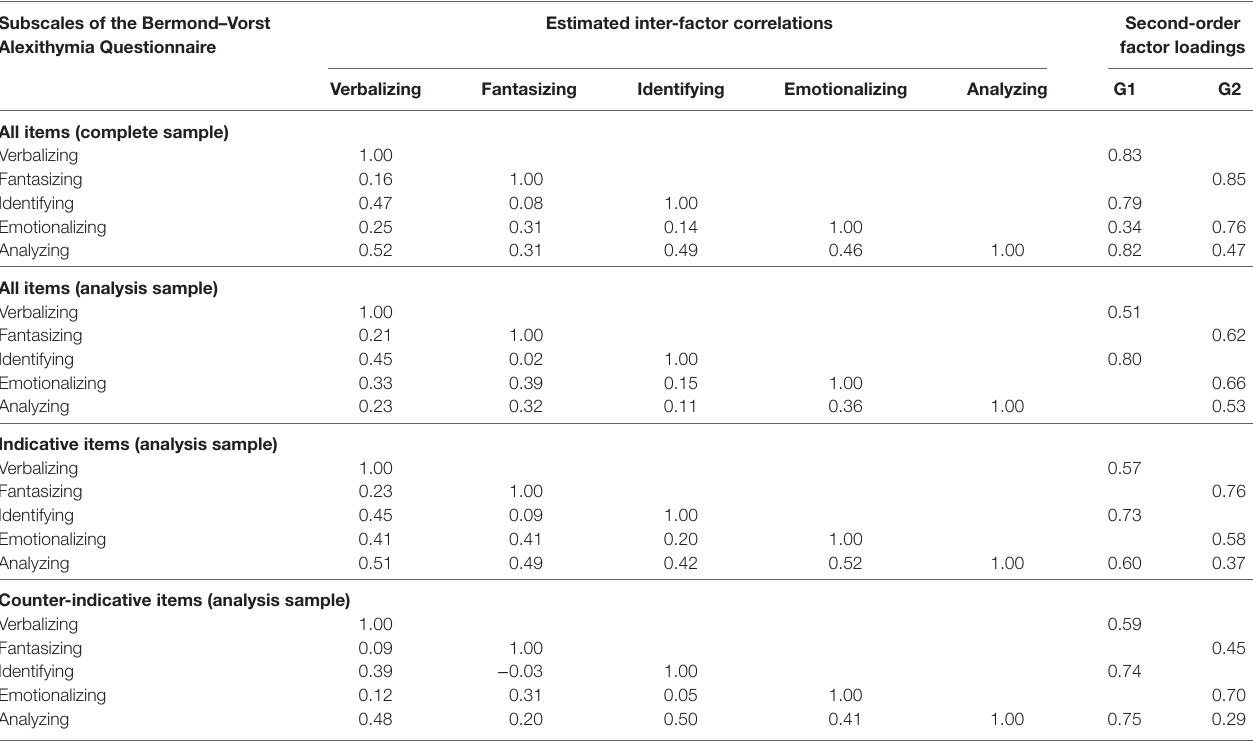
estimated inter-factor